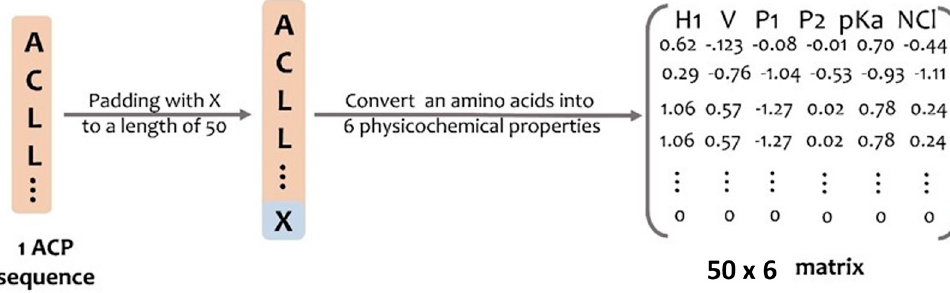
Figure 5. PC6 protein − encoding method. A padded ACP will be transformed into a 50 × 6 matrix.